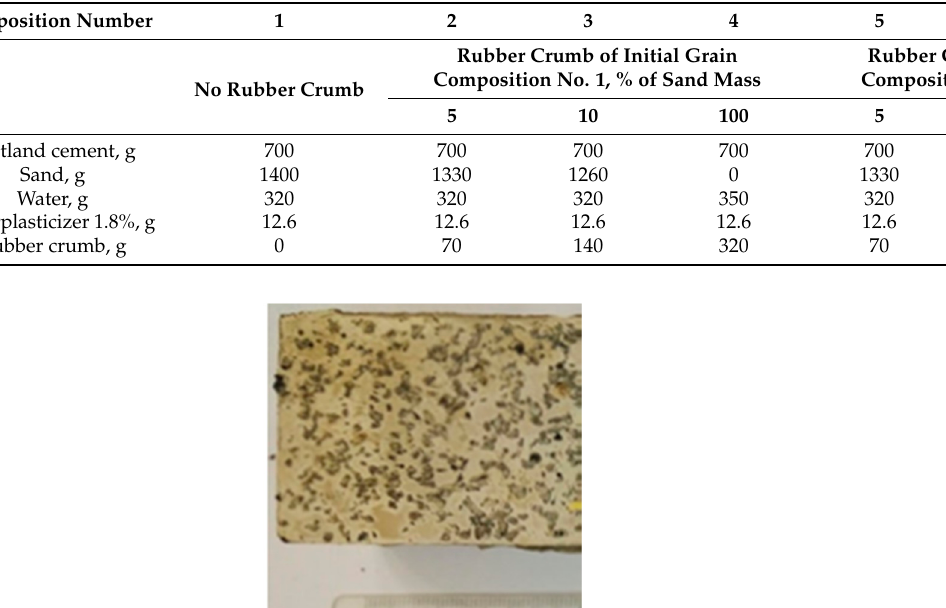
Table 2. Compositions of mortars based on Portland cement.